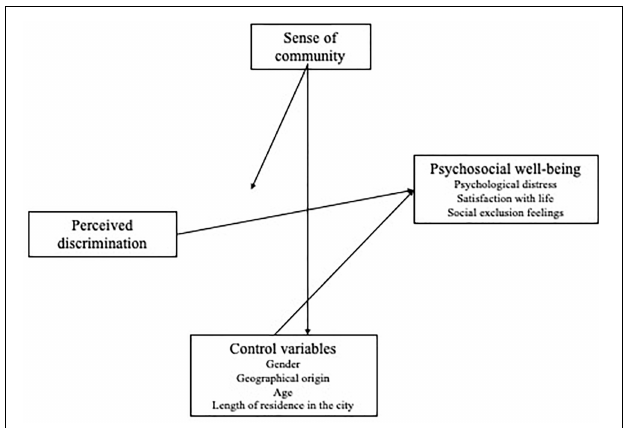
FIGURE 1 | Theoretical